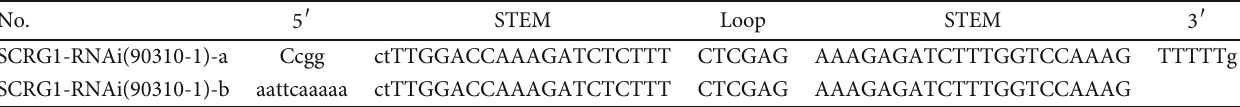
Table 1: Information on shRNA targeting